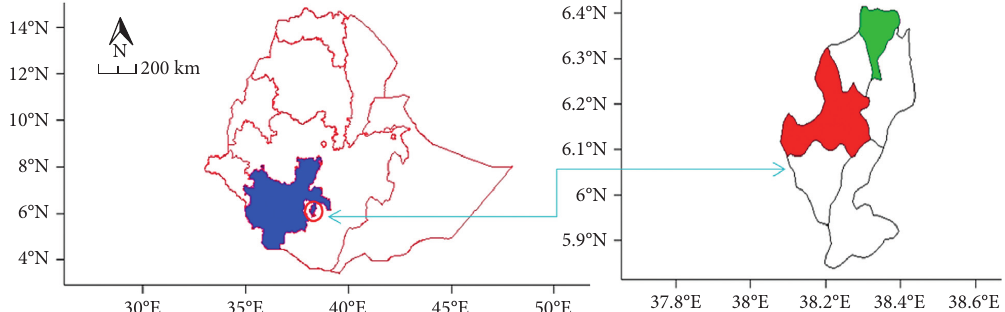
Figure 1: Research site (blue color � SNNPRS; red color � Yirgacheffe; green color �